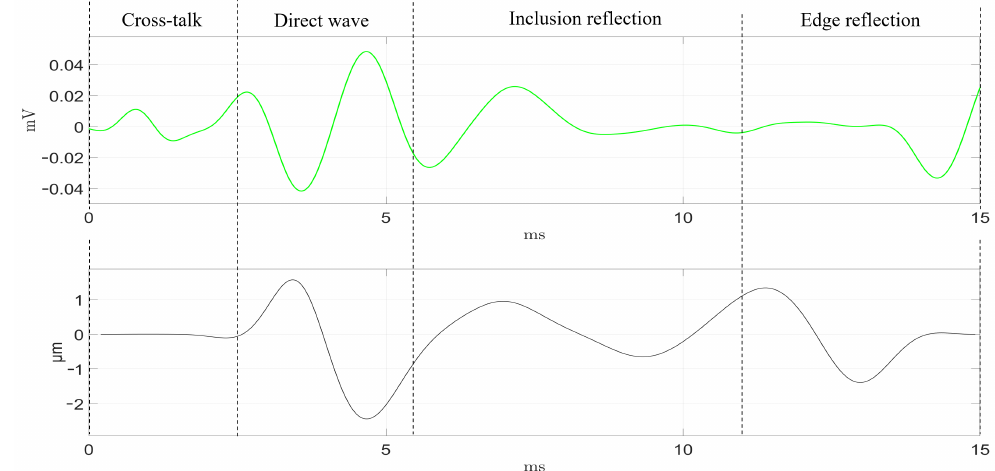
Figure 10. Readout (in green) from the green receiver and the reconstructed displacement (in black) from the ultrasound imaging at a proximal region to the sensor, in phantom